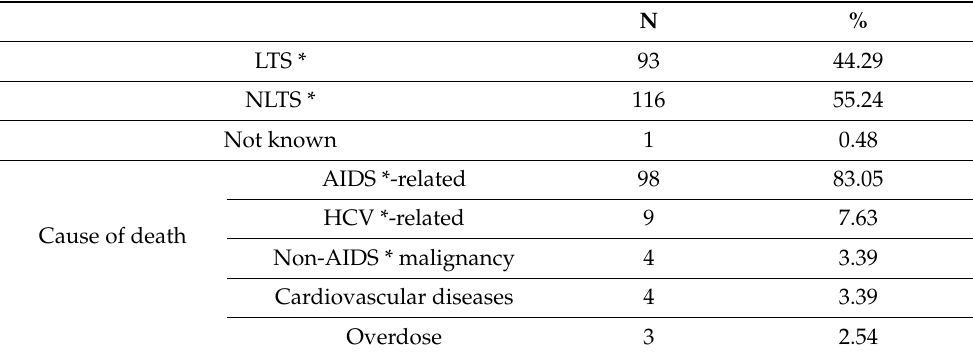
Table 2. Long-term survivors and causes of death.